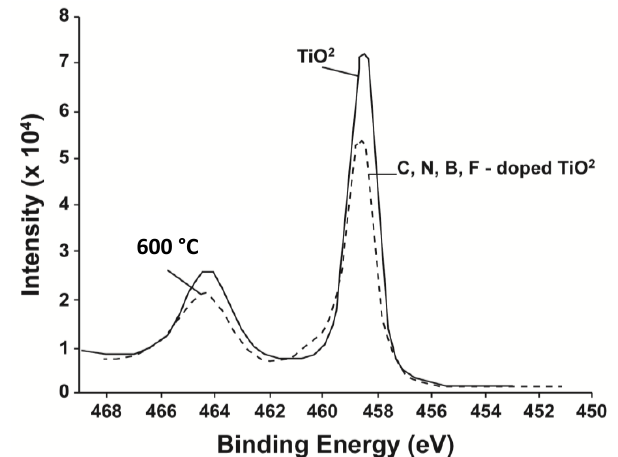
Figure 2. Ti 2p XPS spectra of doped and non-treated TiO 2 samples.